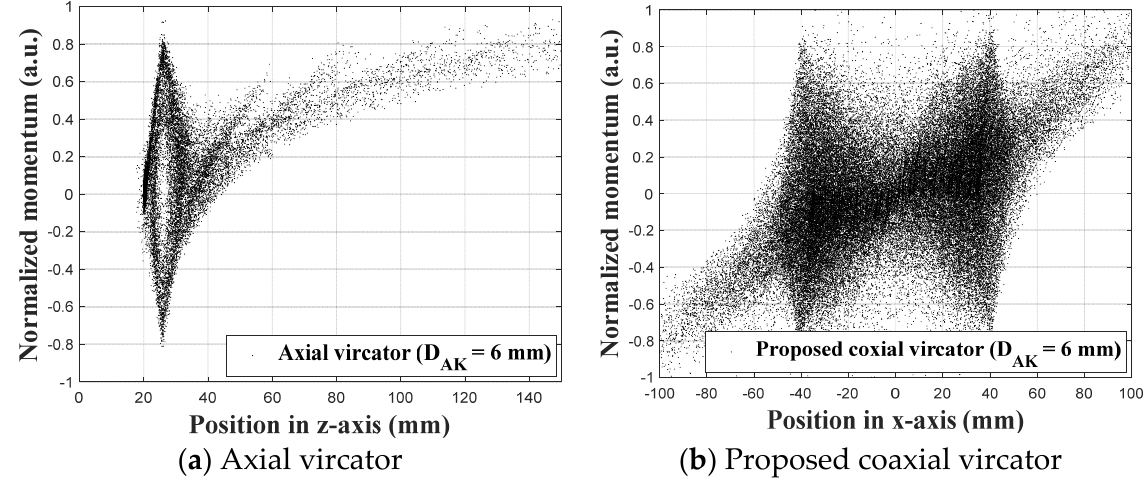
Figure 5. Phase space diagram of the axial and proposed coaxial vircator (D AK = 6 mm).